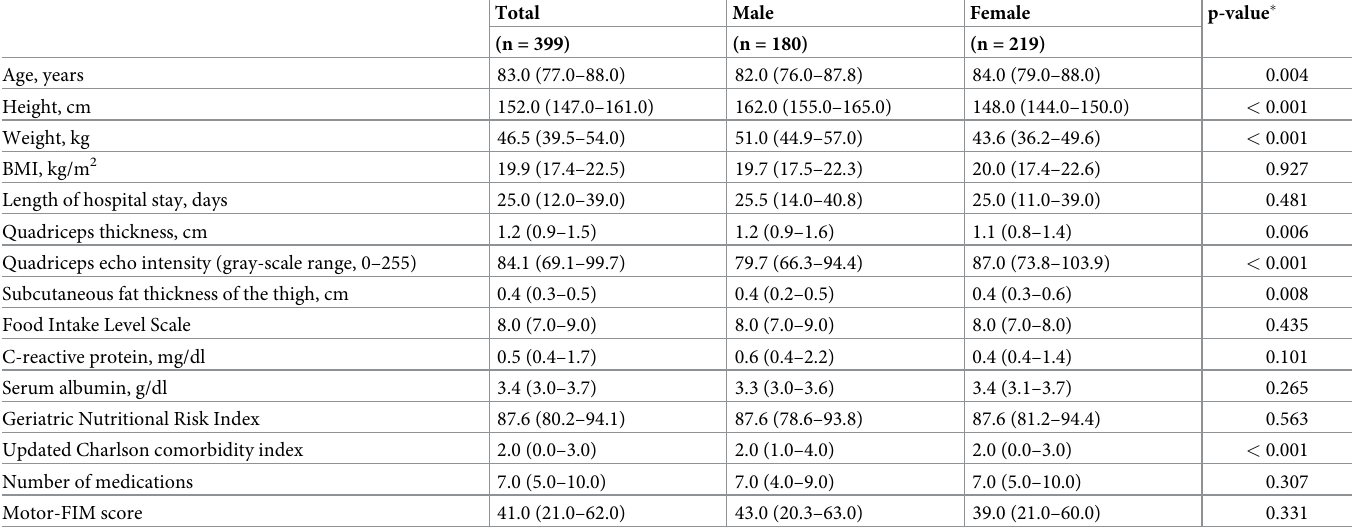
Table 1. Participants’